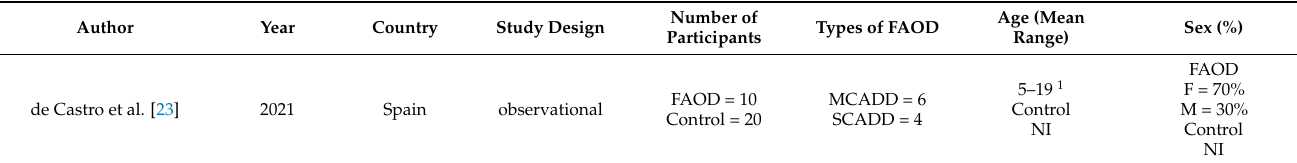
Table 2. Characteristics of the studies with control